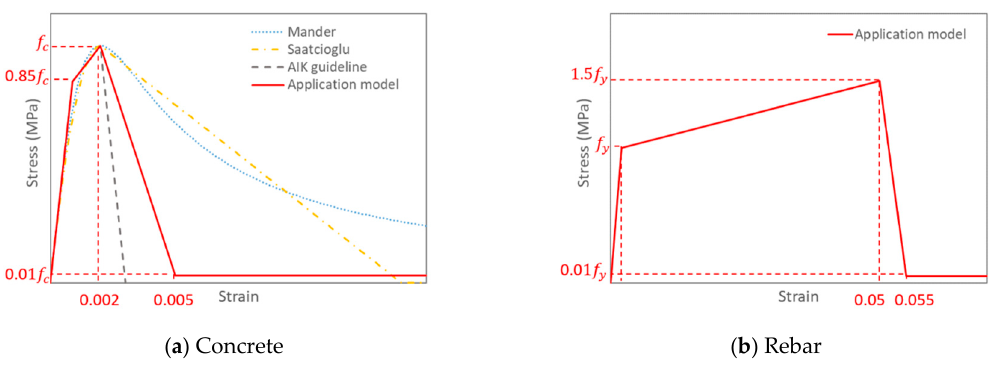
Figure 4. Nonlinear model of concrete and rebar.